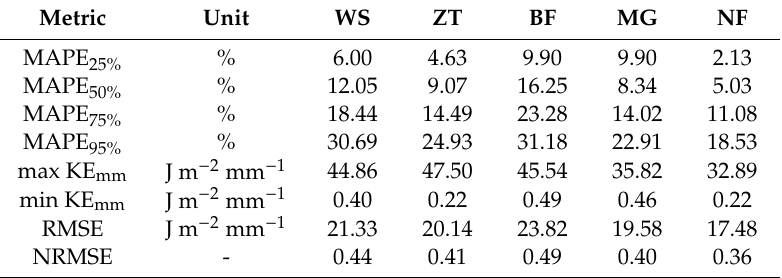
Table 1. Percentile values of MAPE in terms of maximum and minimum values, root-mean-square error (RMSE), and normalized RMSE (NRMSE) between KE mm(E) and . KE mm estimated according to the empirical relations analyzed here (WS, ZT, BF, and MG) and the formulation proposed (NF). Metric